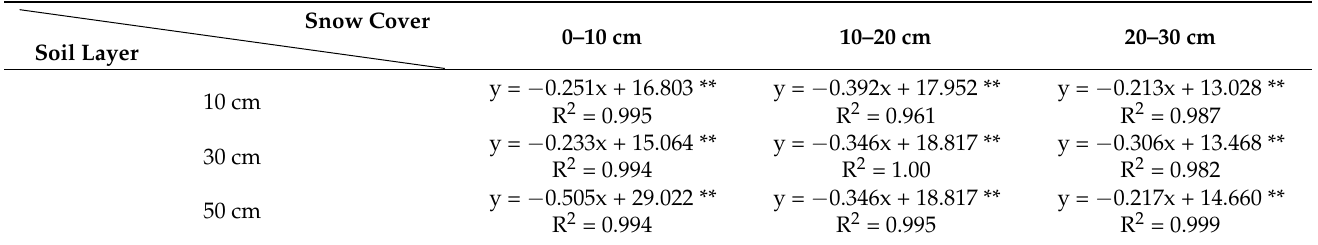
Table 7. Simulation equation of the dynamic process of the contribution of the snow depth to the soil water in the different soil